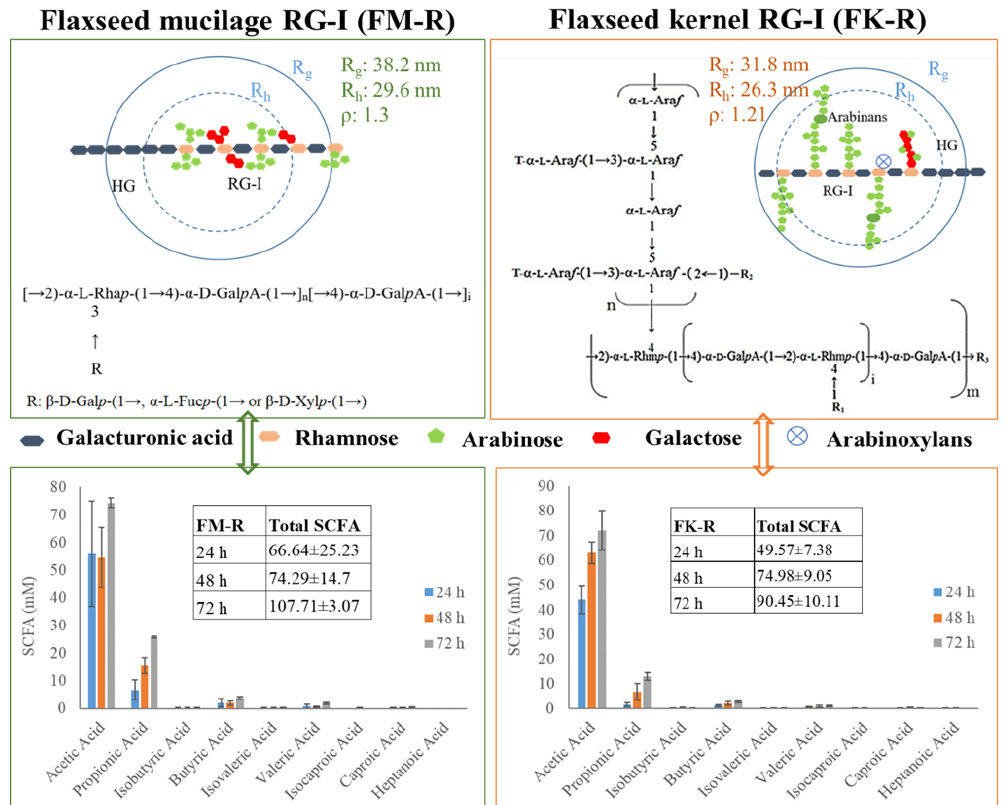
Figure 5. The correlation between the primary structure and conformation of flaxseed mucilage RG-I (FM-R) and flaxseed kernel RG-I (FK-R), and the correlation between the structure/conformation and SCFA profiles after in vitro fermentation; the structure of flaxseed RG-I fractions were reproduced from the results of previous studies [4,5]; SCFA profiles were reproduced from previous results [19].